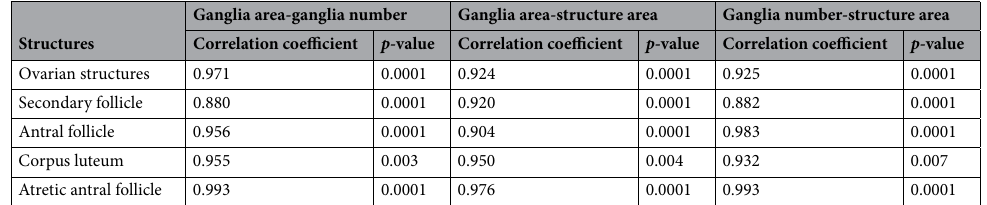
Table 1. Correlation coefficient of follicular area and ganglia development including ganglia number and area in different follicular phases and corpus luteum in two-dimensional ovary analysis.